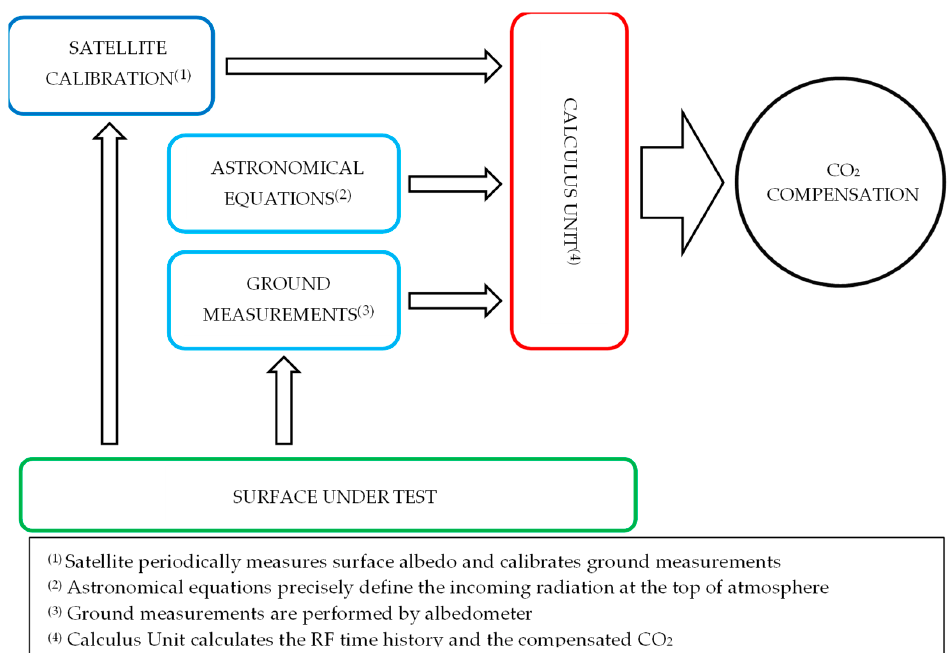
Figure 7. RF -meter synoptic scheme.